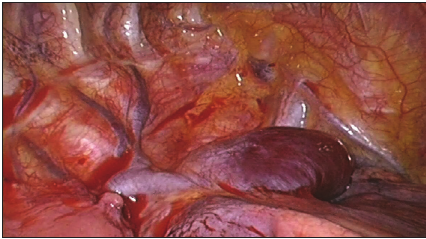
Figure 2: Thoracoscopic surgery revealed a mass arising from the azygos venous arch; there was light adhesion.